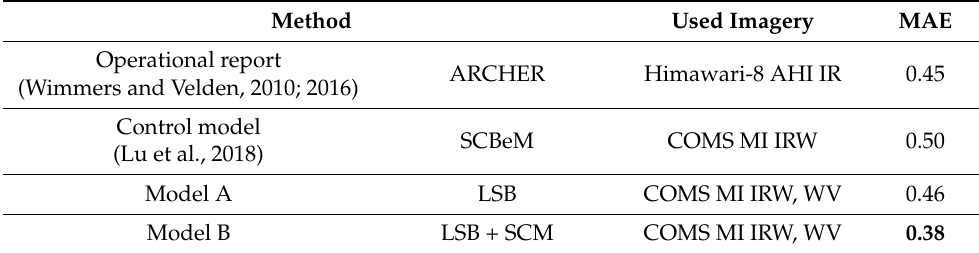
Table 6. Comparison of the model performance of ARCHER, the scheme-1 -based control model, model A , and model B . The best-performing one is marked as bold.